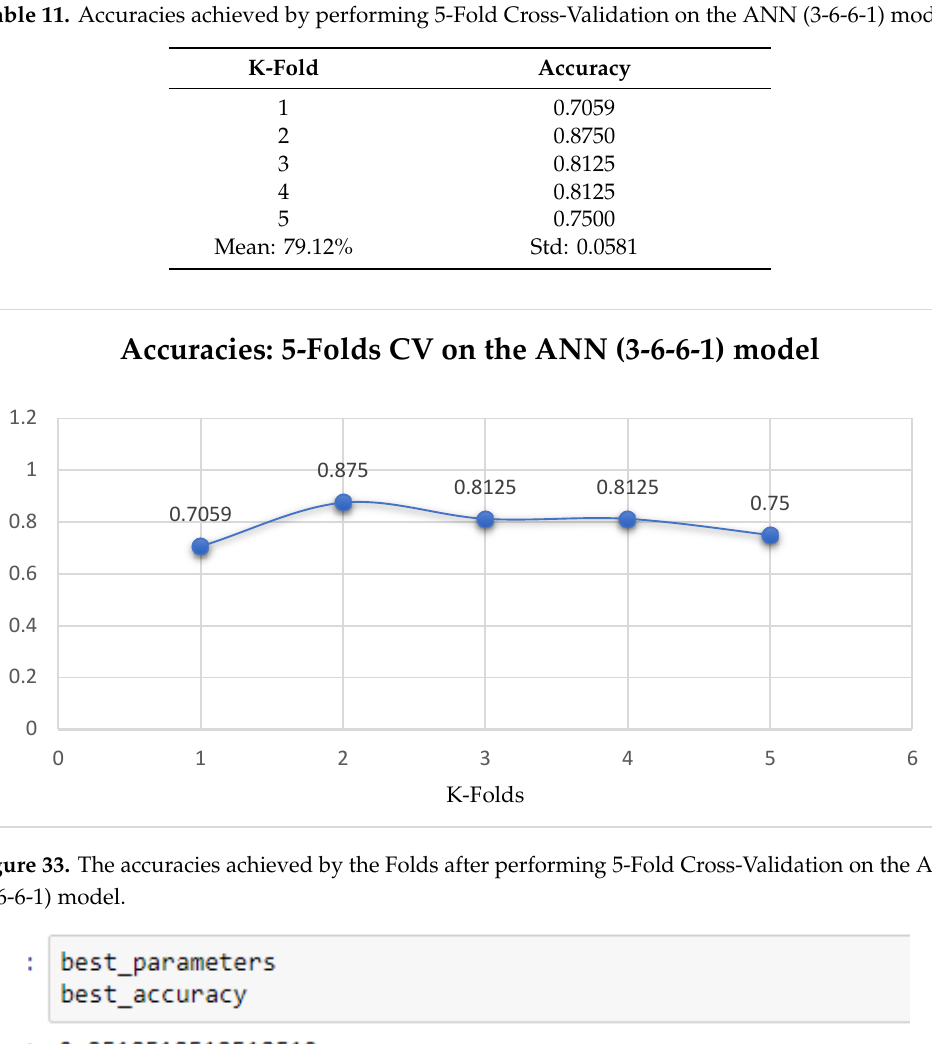
Table 11. Accuracies achieved by performing 5-Fold Cross-Validation on the ANN (3-6-6-1) model.